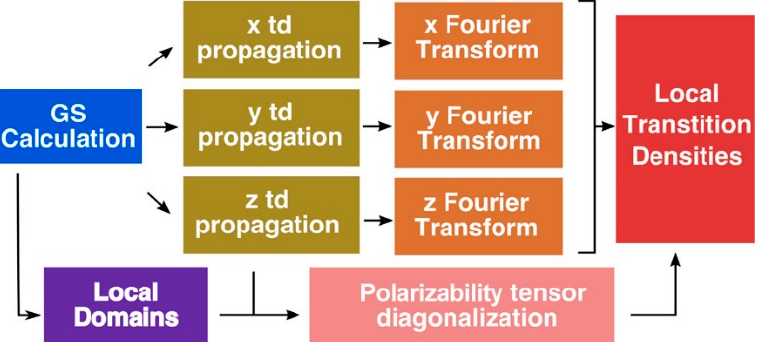
Figure 3. Scheme of the procedure used to get transition dipole moments and transition densities from real-time propagation TD-DFT (P-TDDFT) calculations for multichromophore systems. Reprinted with permission from [53]. Copyright (2019) American Chemical Society (https://pubs.acs.org/doi/abs/10.1021/acs.jctc.9b00209. Further permissions related to the material excerpted should be directed to the ACS).